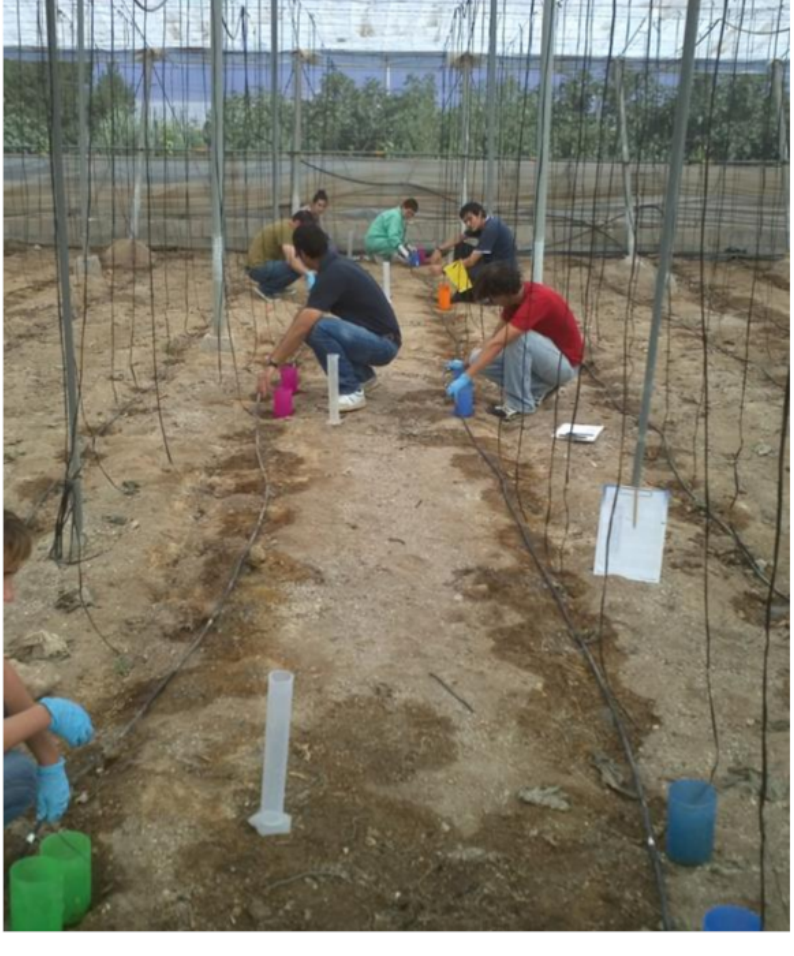
Figure 2. Image of data collection in a